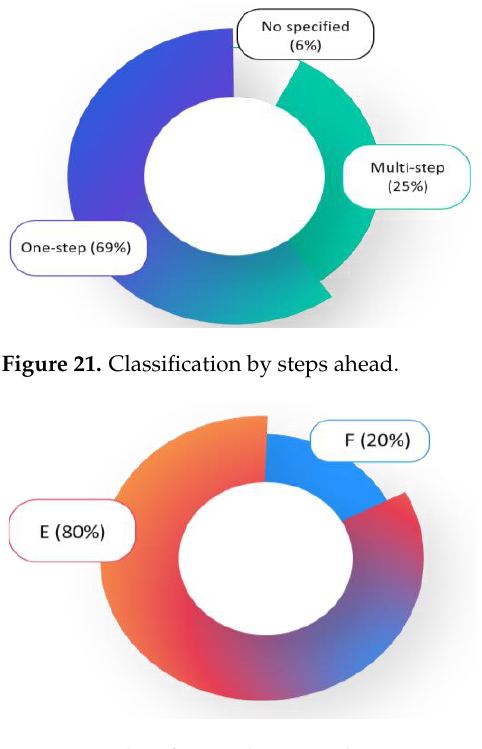
Figure 20. Classification by type of proposed model.